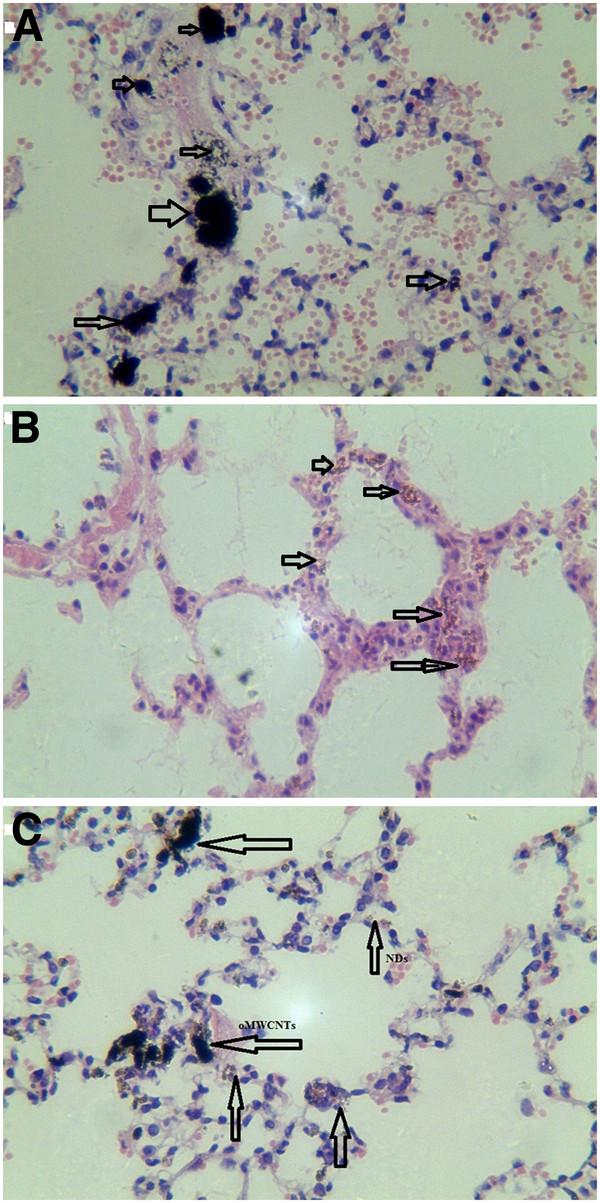
The histology of lung tissues (×20). (A) oMWCNTs, (B) NDs, and (C) oMWCNTs + NDs.